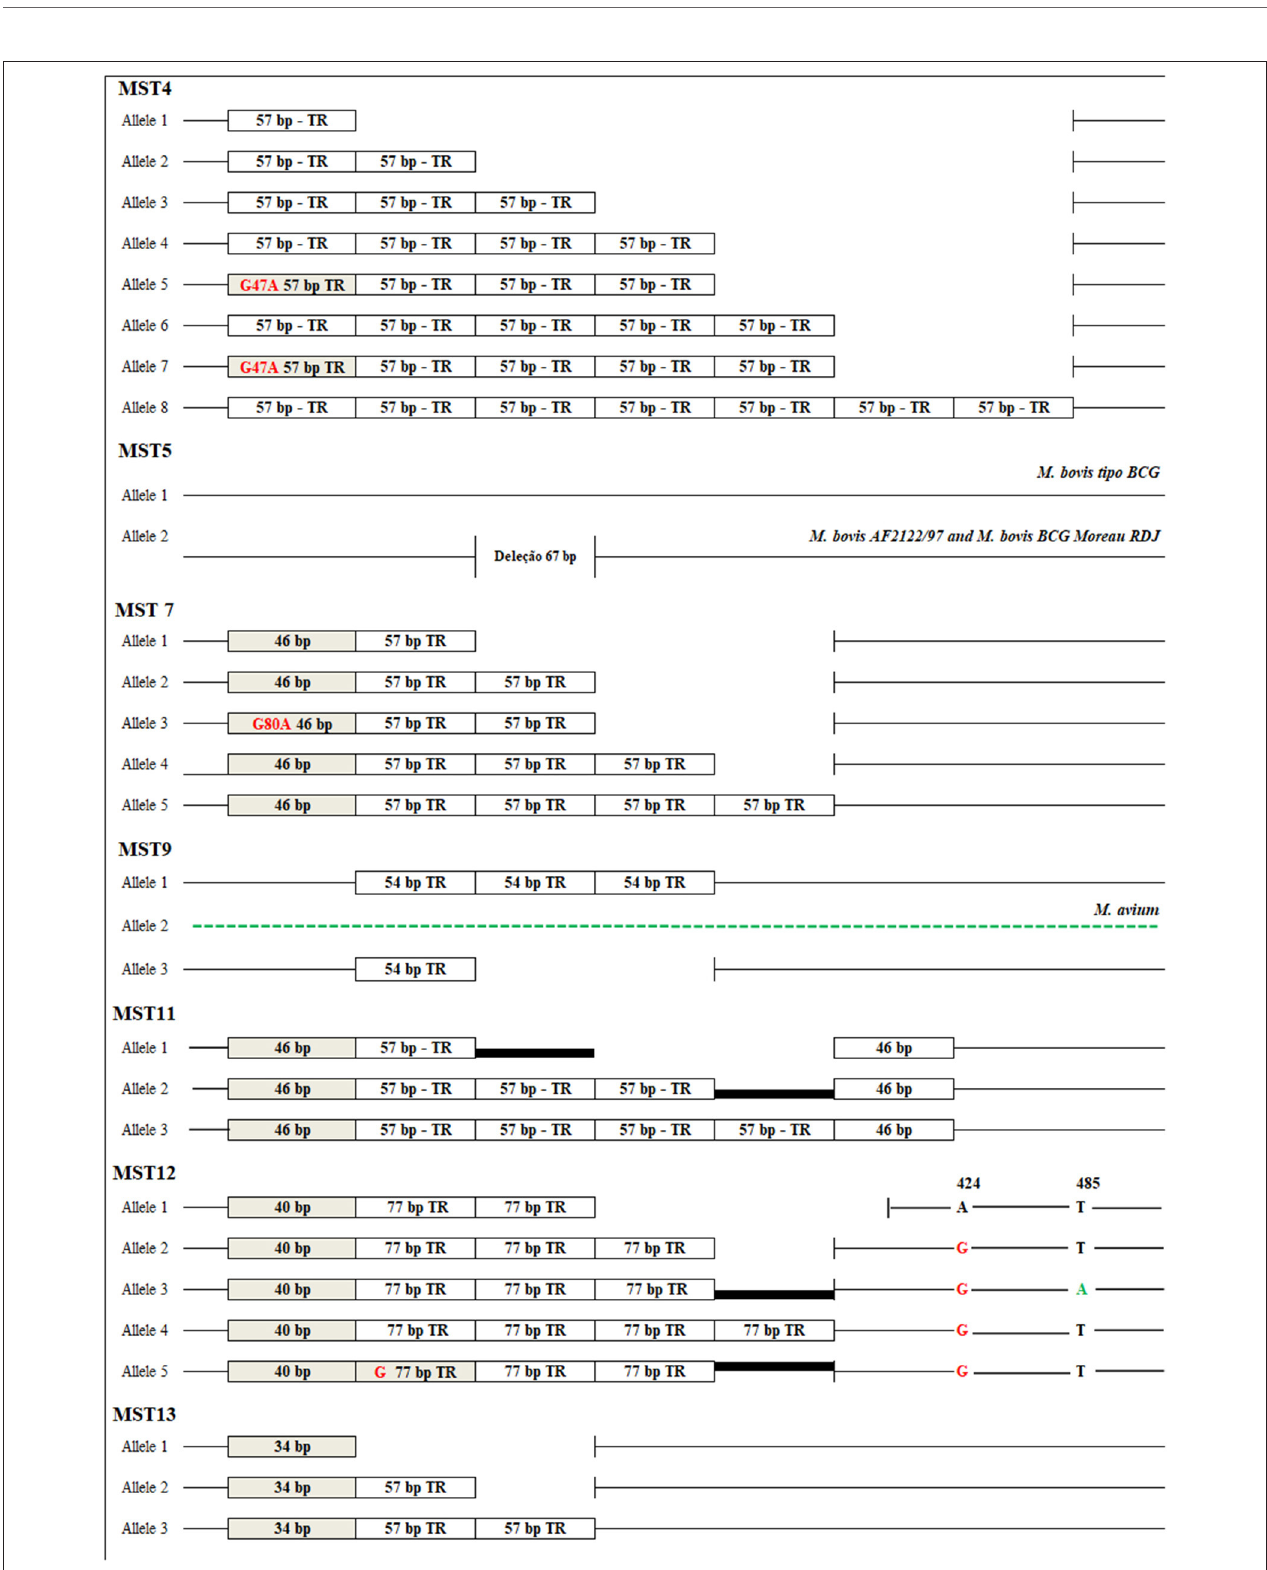
FIGURE 1 | Alleles identified in seven intergenic spacers in Mycobacterium bovis . MST4 (ETR-B): eight alleles containing 1, 2, 3, 4, 5, and 7 copies of the 57 bp tandem repeat sequence (TR) and the presence of a SNP G47A (alleles 5 and 7). MST5: deletion of 67 bp. MST7: Five alleles containing from 2, 3, 4 and 5